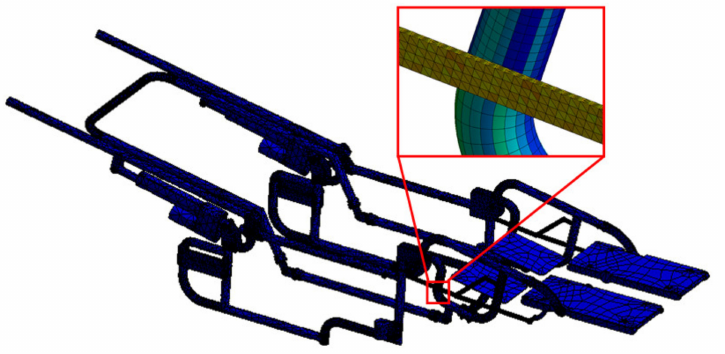
Figure 9. Wheelchair structure mesh.